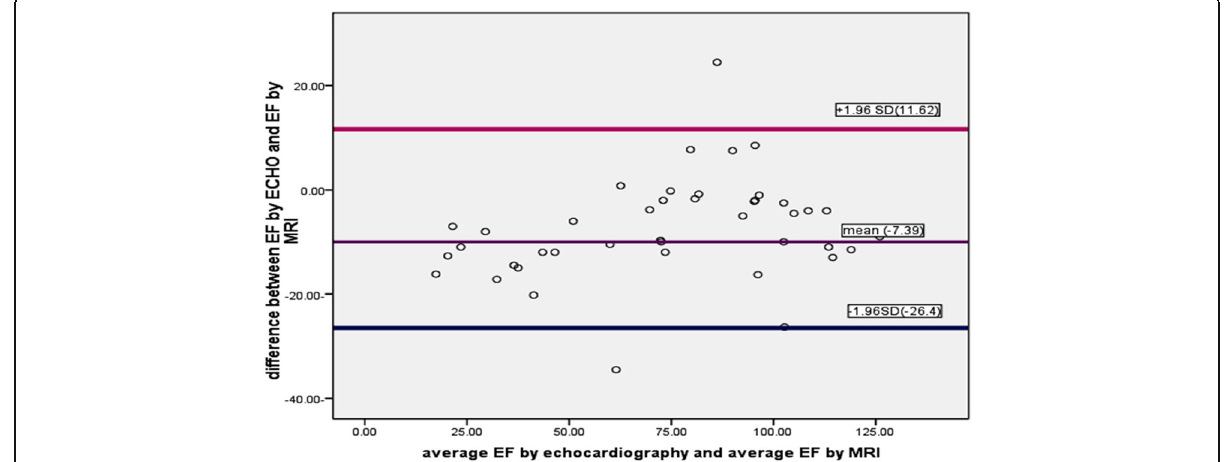
Fig. 2 Bland-Altman plot test for agreement between MRI and echocardiography for measurement of EF